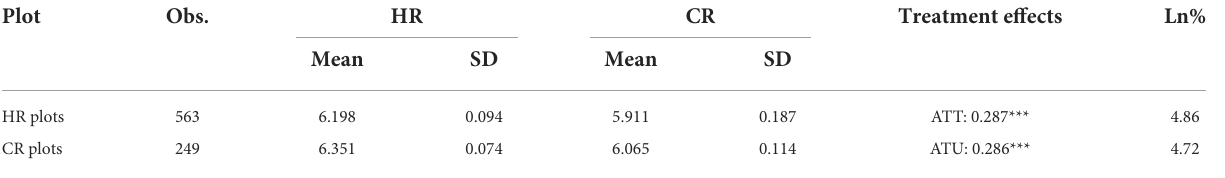
TABLE 3 Average treatment effects of HR on rice yield,